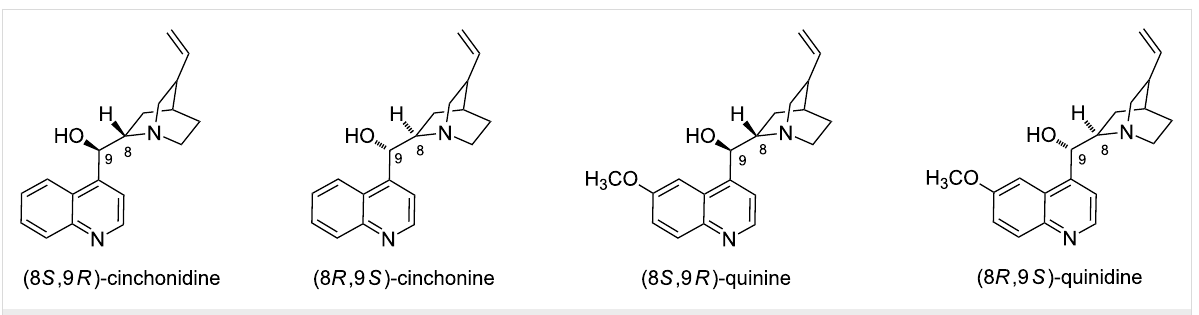
Figure 2: Common cinchona alkaloids (cinchonine, cinchonidine, quinine,